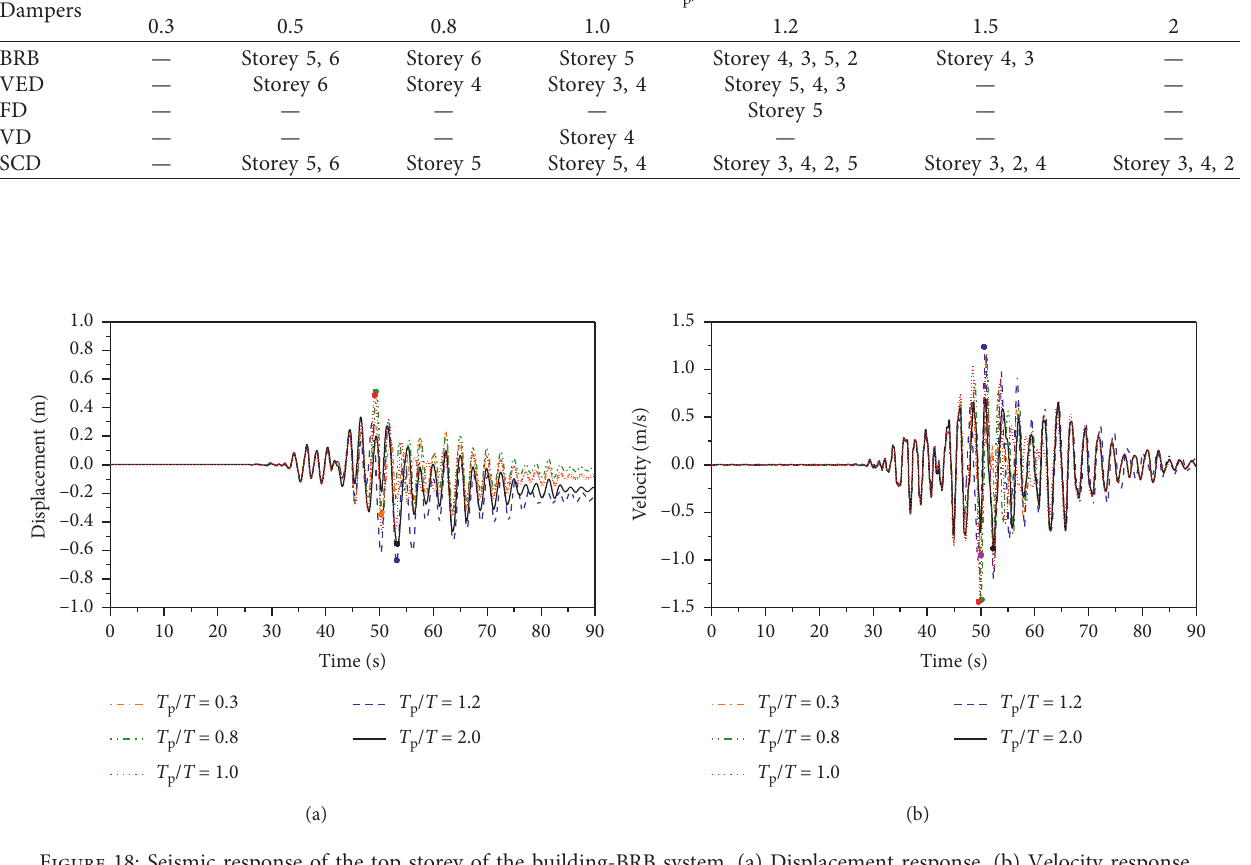
Table 9: Storeys where the five dampers fail under ANEs with different pulse periods.